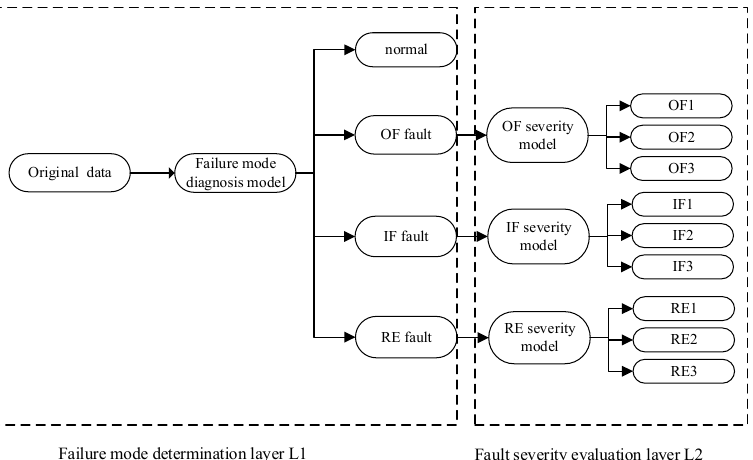
Figure 2. Adaptive hierarchical deep convolutional network (A-HDCNN) model architecture pro- posed in this paper.